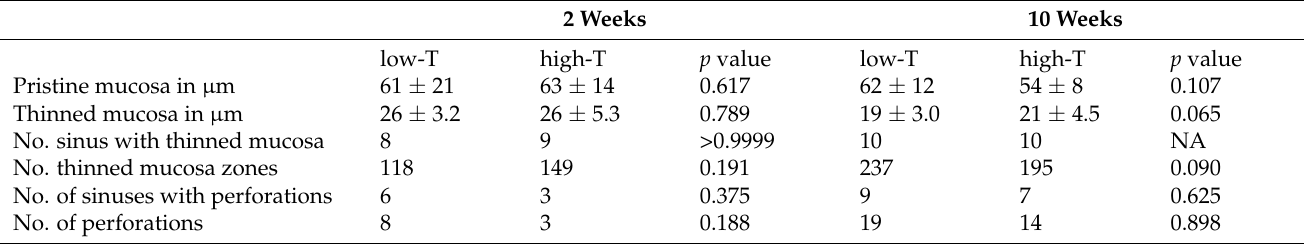
Table 2. Number of sites of thinned mucosa categorized according to the